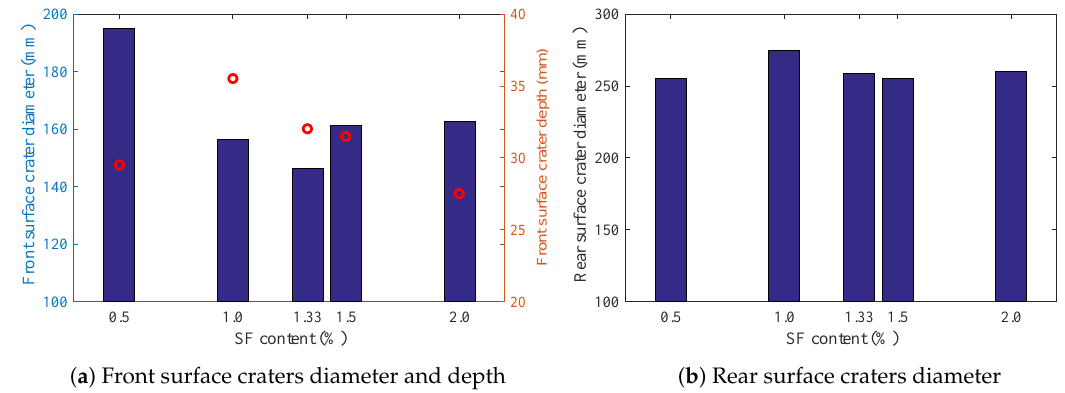
Figure 11. Post-blast front and rear surface craters of PVA-Steel HFRC